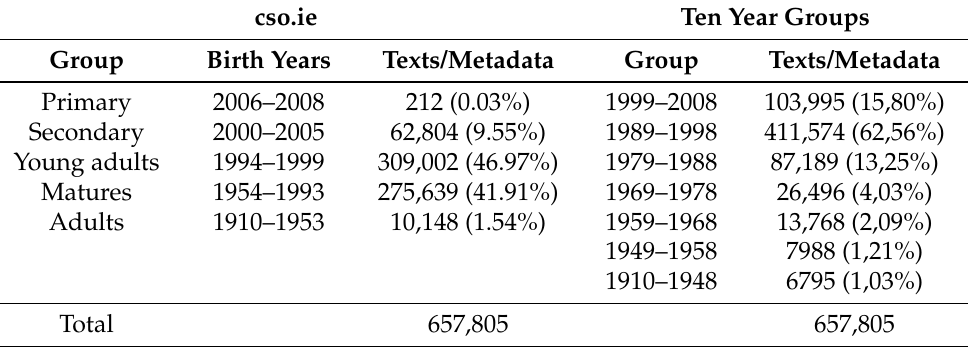
Table 4. Different age cohort descriptors (distributions).